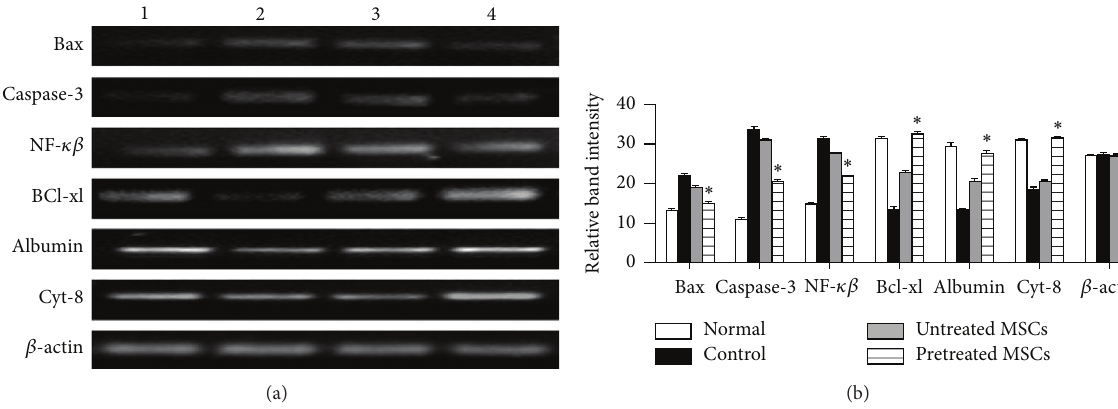
Figure 5: (a) Gene expression profile of MSCs/CCl 4 injured hepatocytes coculture model: (Lane 1) normal hepatocytes, (Lane 2) CCl 4 injured hepatocytes as control, and (Lanes 3 and 4) CCl 4 injured hepatocytes cocultured with untreated and cytokines pretreated MSCs, respectively. (b) Quantification of gel band by image J software: ∗ 𝑃 < 0.05 versus control and untreated MSCs